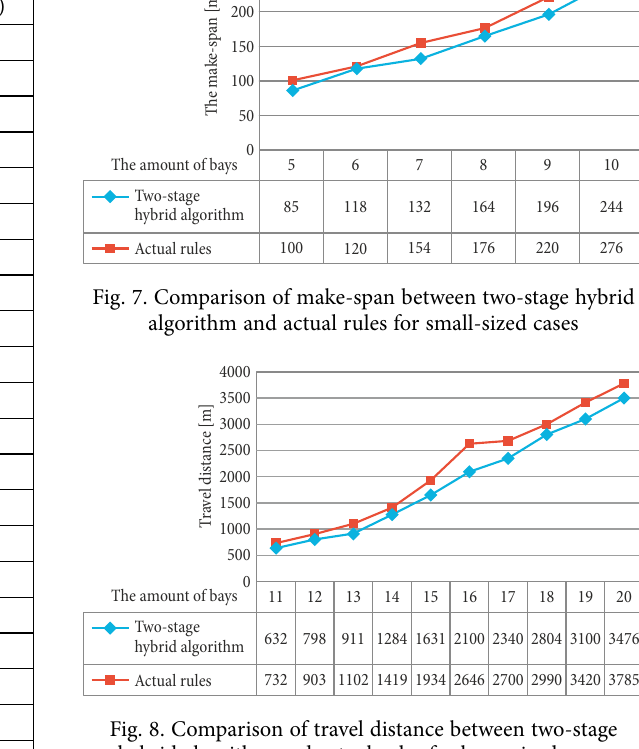
Fig. 8. Comparison of travel distance between two-stage hybrid algorithm and actual rules for large-sized cases